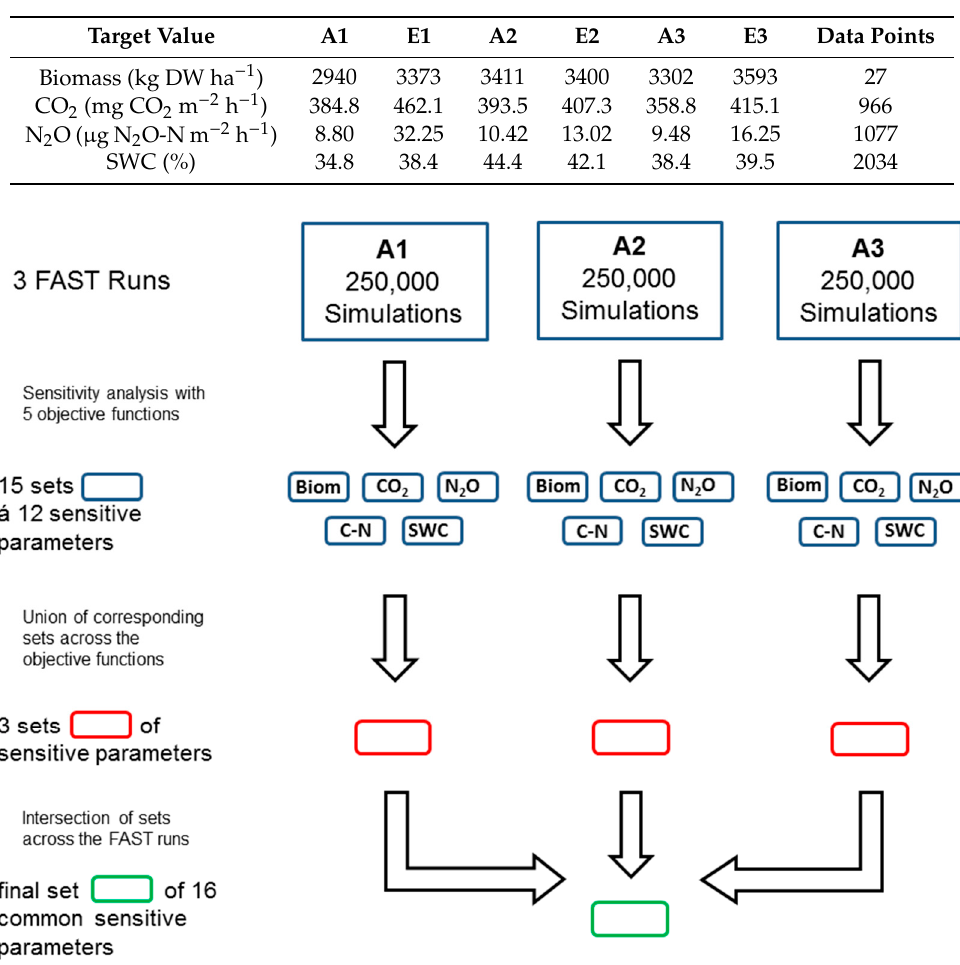
Table A5. Measurement averages and number of measured data points per plot.